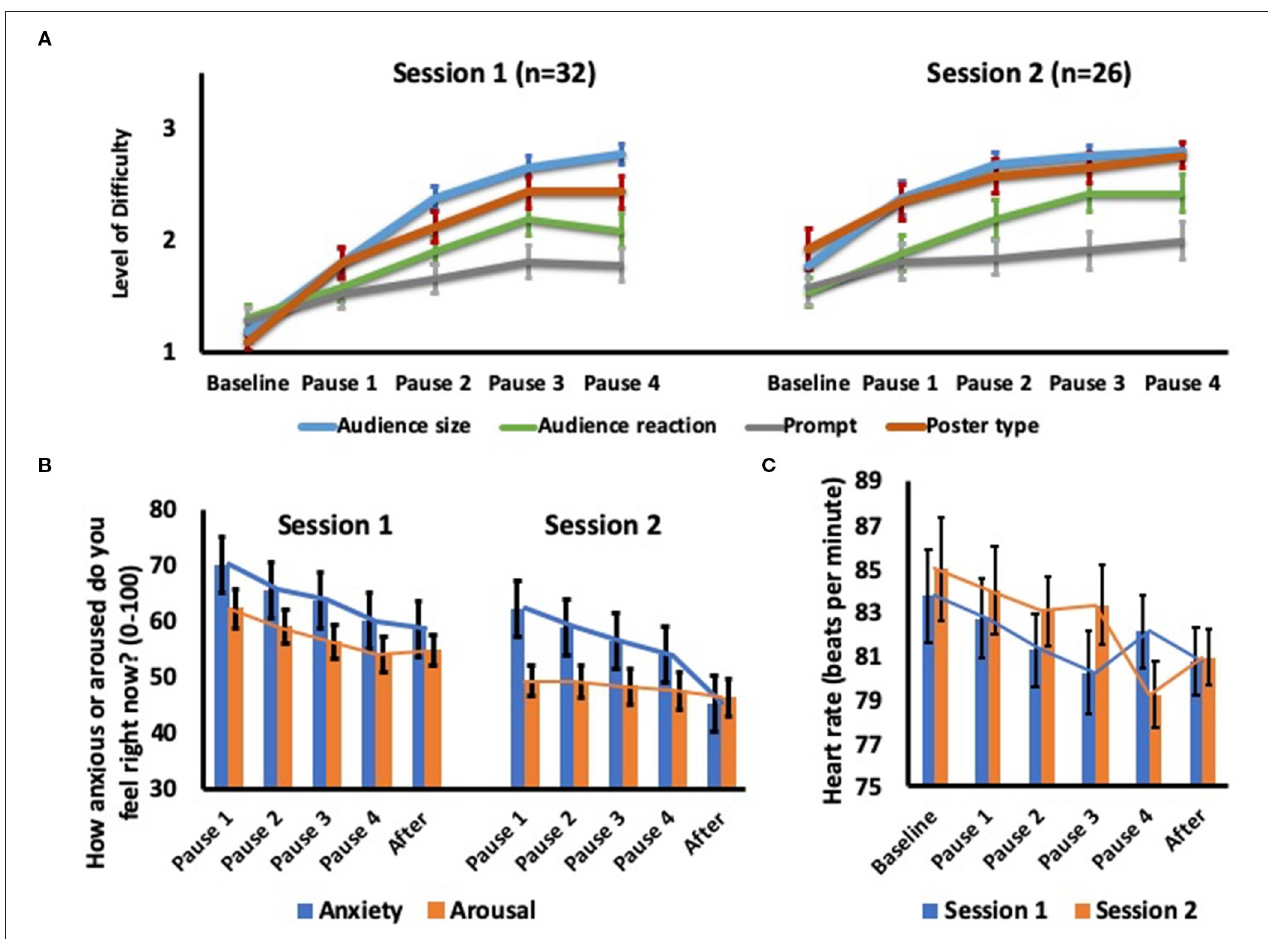
FIGURE 3 | Participant changes in exposure to social threat at each 4-min pause within the virtual environment in (A) modifying the elements of the social threat, (B) anxiety and arousal and (C) heartrate.